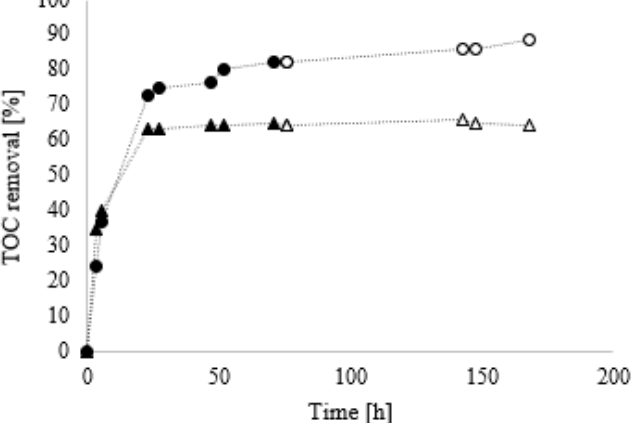
Figure 4. TOC removal % during accelerated biodegradation tests of conditioning mixture A (circle) and B (triangle) with 2.0 mL of Bacillus Clausii . First cycle of treatment (full symbols) and second cycle (empty symbols).